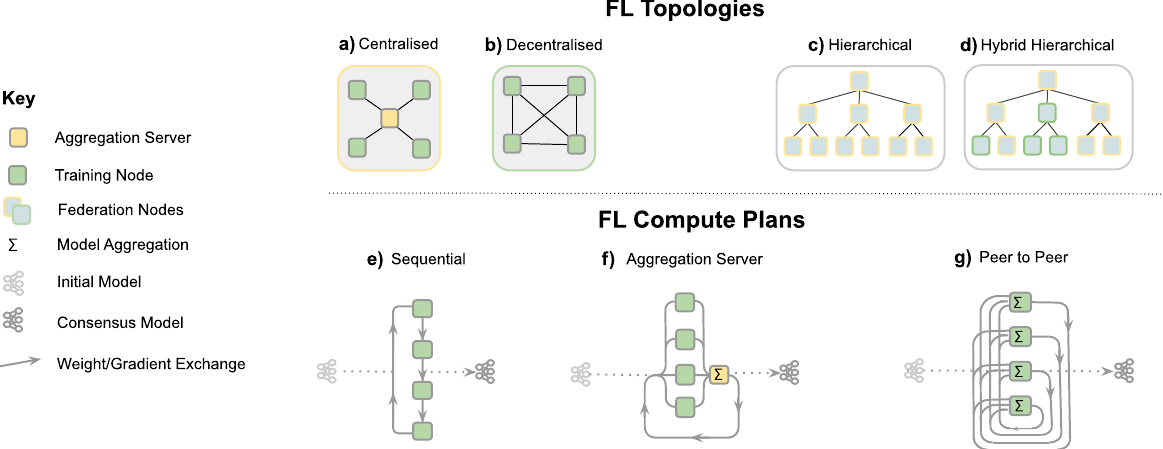
Fig. 2 Overview of different FL design choices. FL topologies — communication architecture of a federation. a Centralised: the aggregation server coordinates the training iterations and collects, aggregates and distributes the models to and from the Training Nodes (Hub & Spoke). b Decentralised: each training node is connected to one or more peers and aggregation occurs on each node in parallel. c Hierarchical: federated networks can be composed from several sub-federations, which can be built from a mix of Peer to Peer and Aggregation Server federations ( d )). FL compute plans — trajectory of a model across several partners. e Sequential training/cyclic transfer learning. f Aggregation server, g Peer to